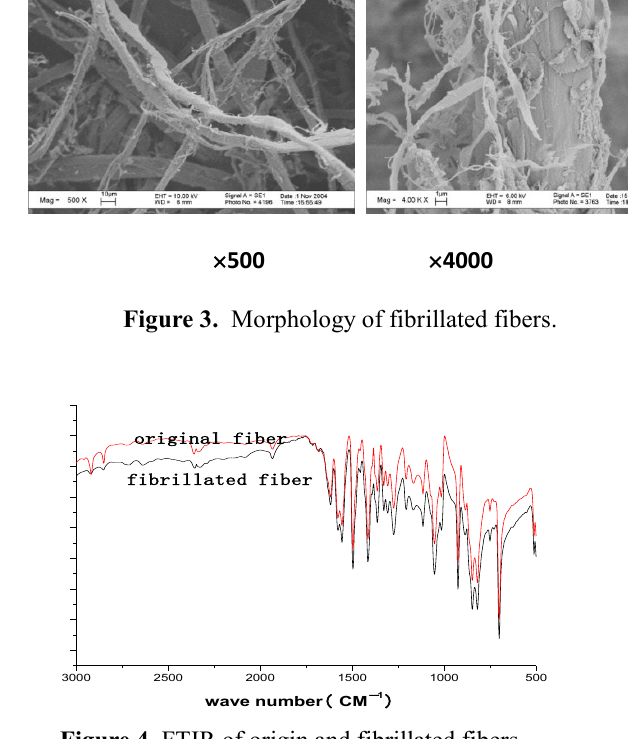
Figure 4. FTIR of origin and fibrillated